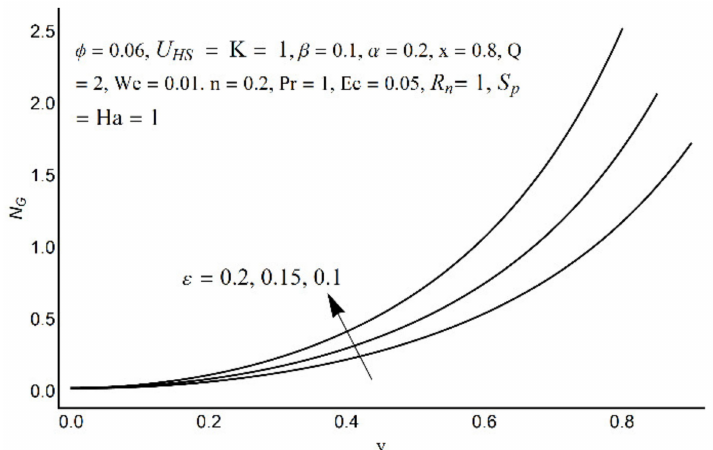
Figure 17. Entropy generation number for different values of ε .